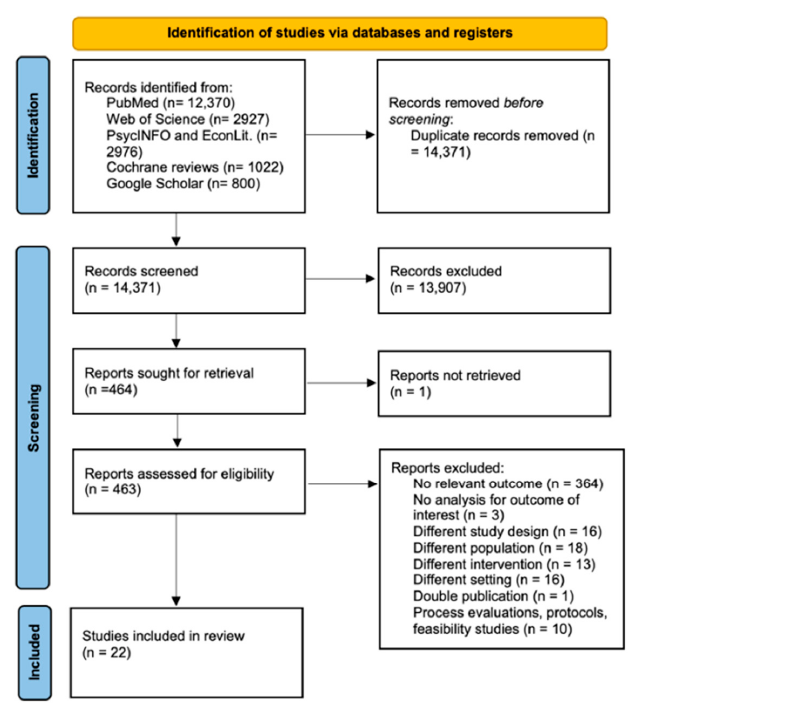
Figure 1. PRISMA flow diagram of study selection.